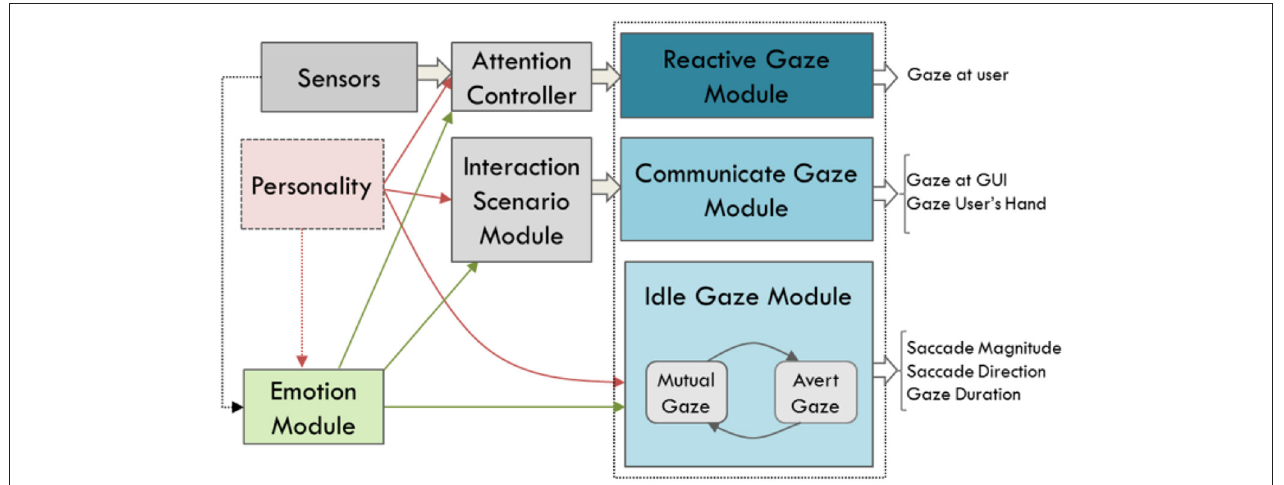
FIGURE 4 | Structure of the Gaze Control module. Reactive gaze has a high level in the hierarchy and is responsive to environment changes. Communicative gaze is responsive to the agent’s goal and scenario of the interaction. Idle gaze has a low level of importance, and other gaze behaviour will overwrite them.